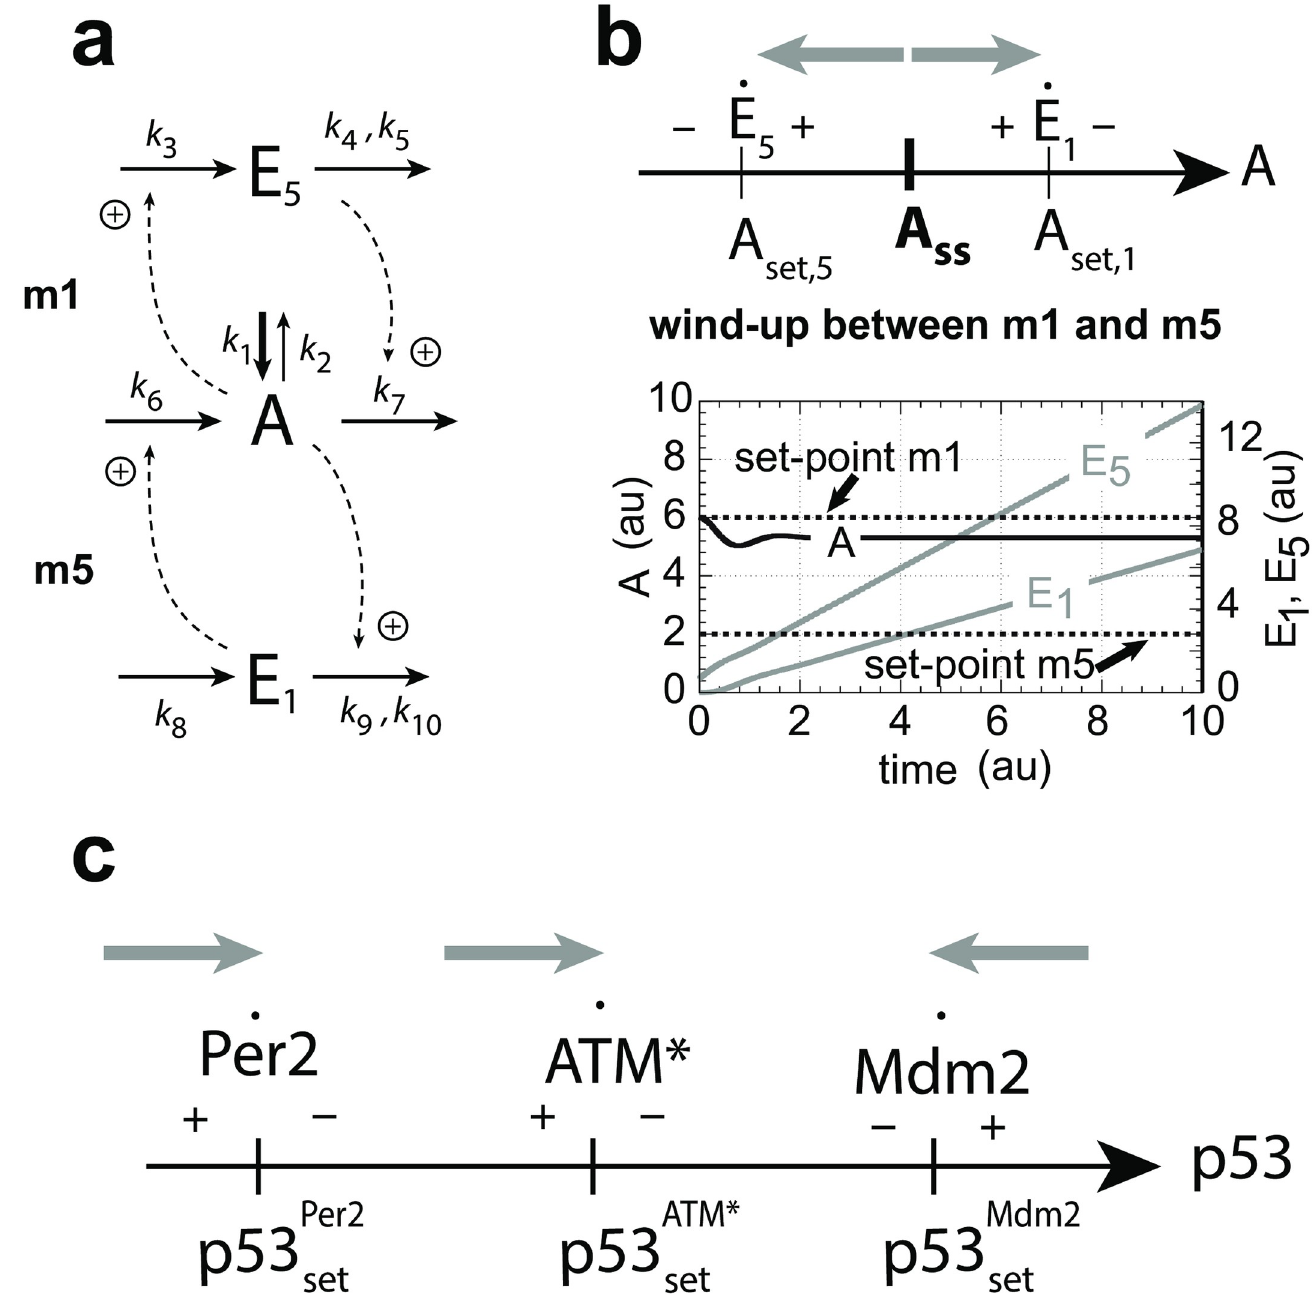
Fig 13. Cooperative and dysfunctional wind-up behavior in combined negative feedback loops. (a) Combined controllers m1 and m5 (S3 Text). (b) Wind-up behavior when A set ,1 > A set ,5 . Because _ E and _ E meet each other in this case with positive signs, each controller pulls in the direction of its own set-point (gray 1 5 arrows). As a result, E 1 and E 5 increase continuously and the controlled variable A lies somewhere between the two set-points dependent on the individual aggressiveness [18] of m1 and m5. S3 Text shows in addition the cooperative behaviors of the two controllers when set-points are switched. (c) Cooperative behavior of the Per2, ATM � , and Mdm2 controllers with respect to p53 regulation. Gray arrows show the direction in p53-concentration space into which each controller pulls.